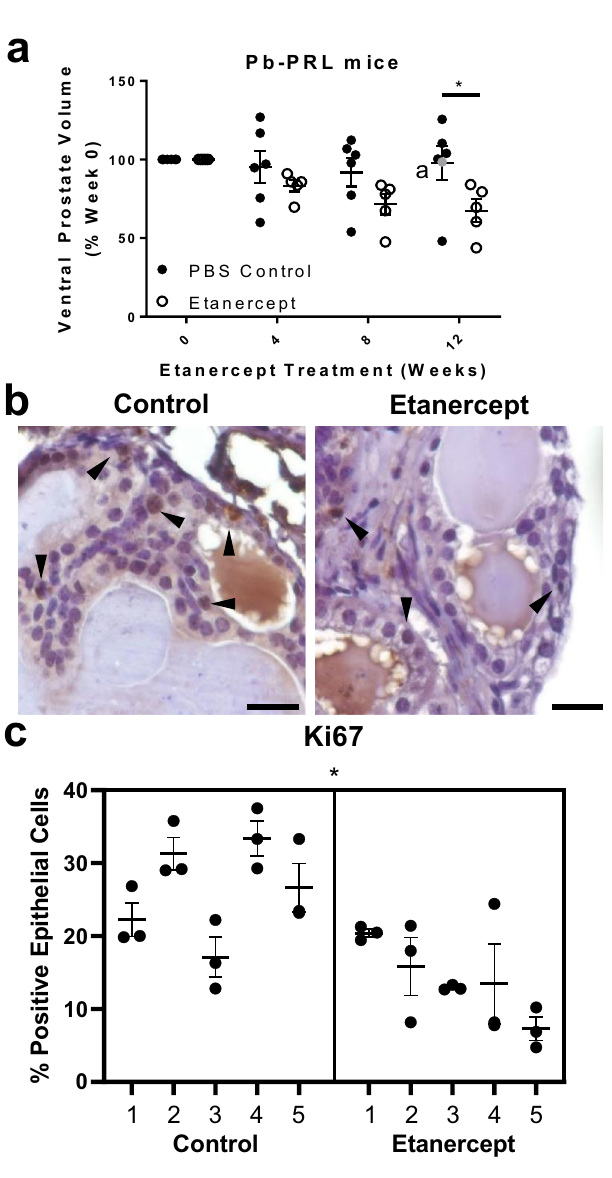
Fig. 2 Analysis of CD45 + cells from human BPH tissues indicate macrophages express high levels of TNF and TNF receptors. a CD45 IHC in human prostate transition zone from small or large prostates ( n = 4 patients per group). Staining was con fi rmed in two independent experiments. Brown color indicates positive CD45 staining and scale bars = 500 µ m. b Human prostate transition zone from small or large prostates ( n = 10 patients per group) were digested, stained, and analyzed by fl ow cytometry. Graph indicates % CD45 + cells, gated on viable cells. A signi fi cant difference in %CD45 + cells (** p = 0.0021) using a two-tailed t test. Error bars represent the mean ± SEM. Source data are provided as a Source Data fi le. c Schematic representing the setup for scRNA-seq studies of human BPH leukocytes (CD45 + cells). A total of 10 small and 4 large prostate transition zone tissues were digested and CD45 + EpCAM - CD200 − cells sorted by FACS. scRNA-seq was conducted using the 10X Chromium system, aiming for 5000 cells/sample at a depth of 50,000 reads/cell. d – f scRNA-seq of BPH associated leukocytes. d Uniform manifold approximation and projection (UMAP) plot of 69,850 individual cells from 14 patient samples, demonstrating dominant T cell and macrophage populations. Each color indicates a unique cell cluster. e Dot plot of the top 4 marker genes from each cluster ranked by fold-change. Gene names are shown on the x -axis and clusters on the y -axis. The size of the dots corresponds to the percentage of cells in a given cluster that express the marker gene. The color of the dots represents the mean log 2 (counts + 1) of each gene in the corresponding cluster. f Feature plots highlighting gene expression of CD68 , TNF , TNFRSF1A (TNFR1), and TNFRSF1B (TNFR2), where the blue color indicates elevated expression of the indicated gene. a indicates a small contaminating epithelial population as cluster 12.